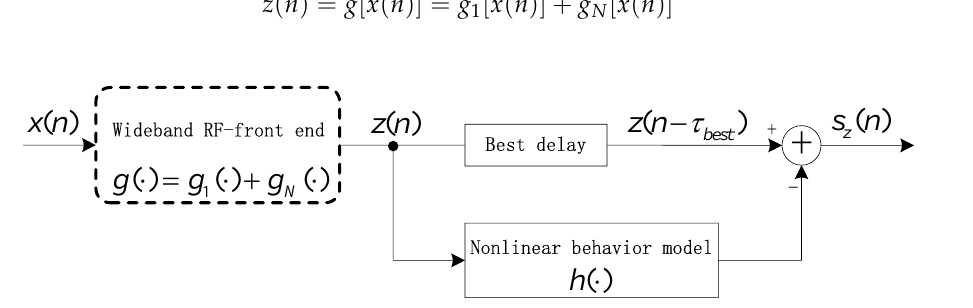
Figure 3. Principle of nonlinearity mitigation.